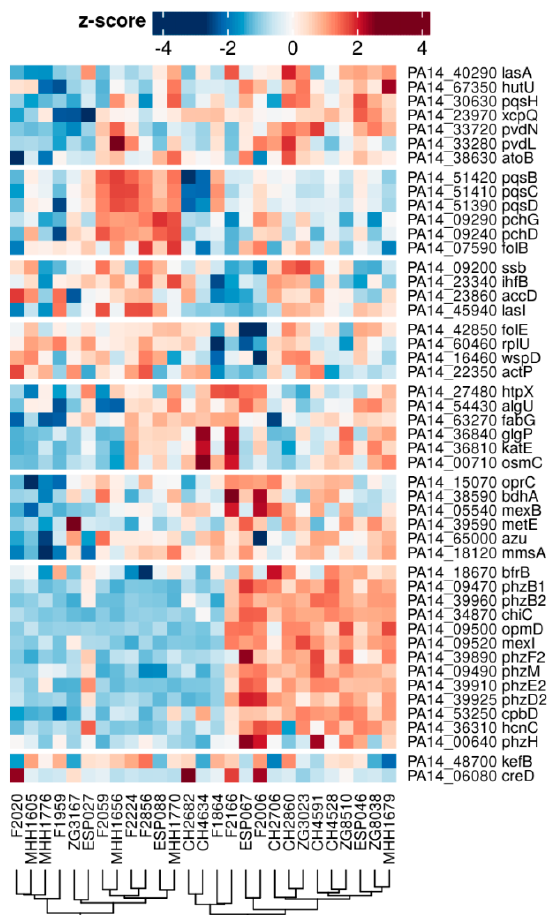
Figure 4. Distribution of expression patterns for variable proteins under biofilm condition.Out of the 10% most variable expressed proteins under biofilm conditions, 48 are annotated and listed here. The full list of variably expressed genes—also for planktonic conditions—is presented in Appendix Figure A2B,C.